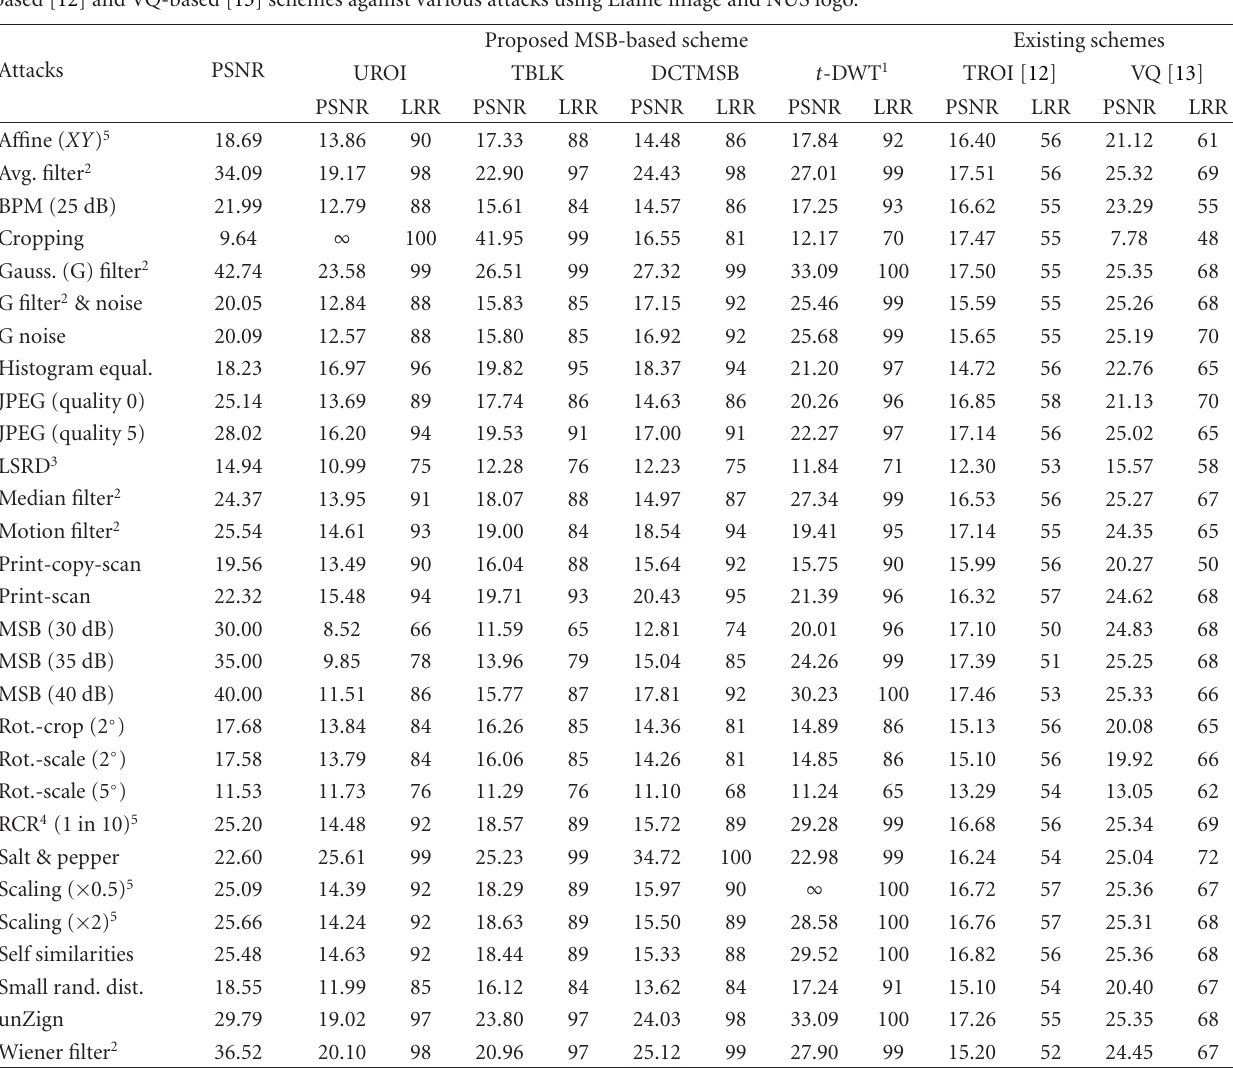
Table 5: Experimental results (PSNR in dB and LRR in %) by di ff erent approaches of the proposed MSB-based scheme and existing TROI- based [12] and VQ-based [13] schemes against various attacks using Elaine image and NUS